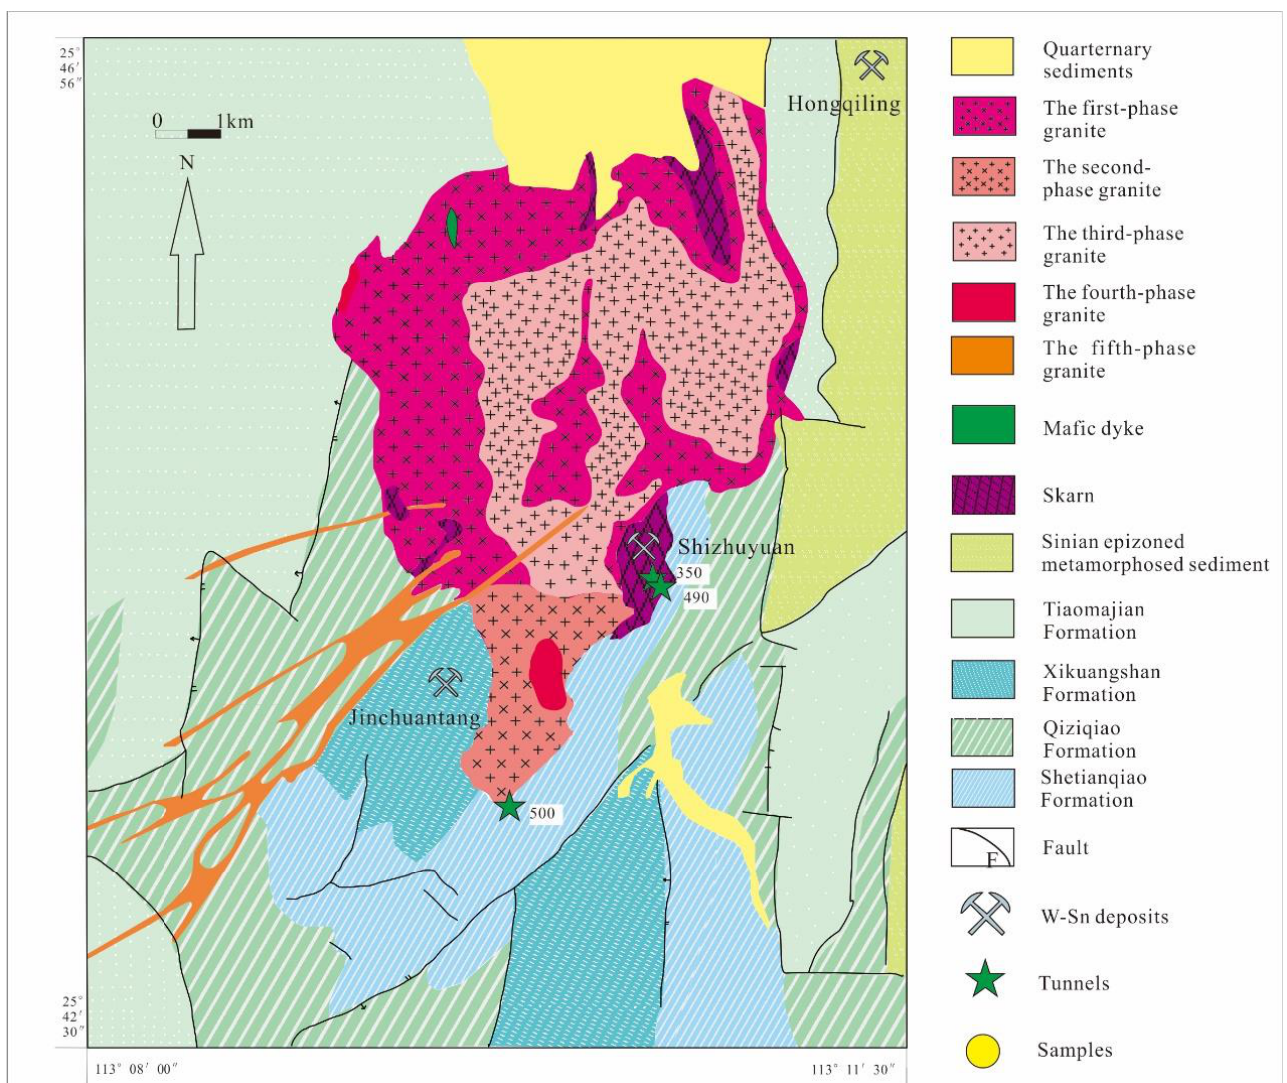
Figure 2. Schematic geological map of the Qianlishan district showing the Qianlishan granite complex (modified after [10,14] ).